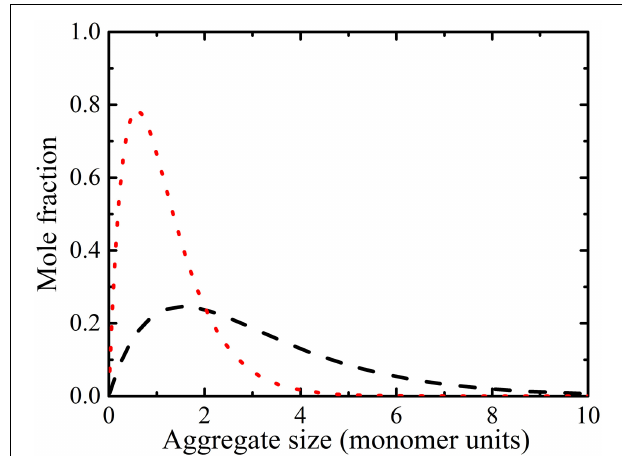
FIGURE 5 | Experimentally measured (i.e., NMR) derived diffusion coefficients of the residual water molecules in D 2 O as a function of the concentration of glycine ( ), alanine ( ), valine ( ) and phenylalanine ( ). The error bars for the measurements are also included; however, the errors are much smaller than the drawn